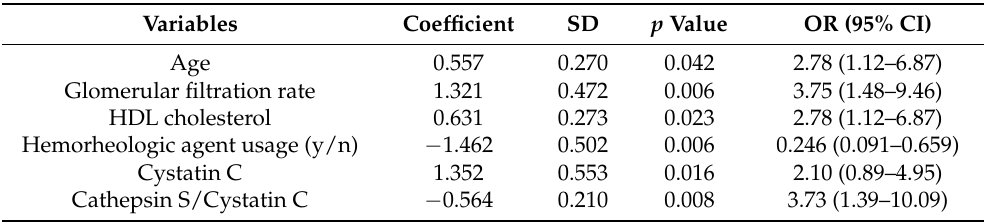
Table 6. Summary of univariate logistic regression of variables associated with polyvascular disease ( n = 3 arterial beds